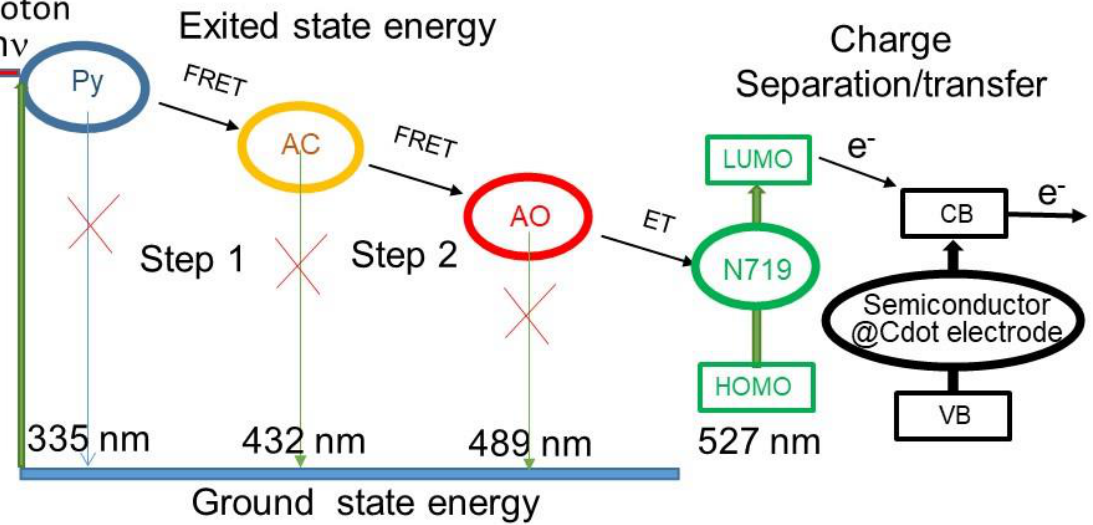
Figure 8. Schematic diagram of energy transfer from cascade FRET fluorophores to N719 and charge separation/transfer in semiconductor@Cdot@N719 DSSC.